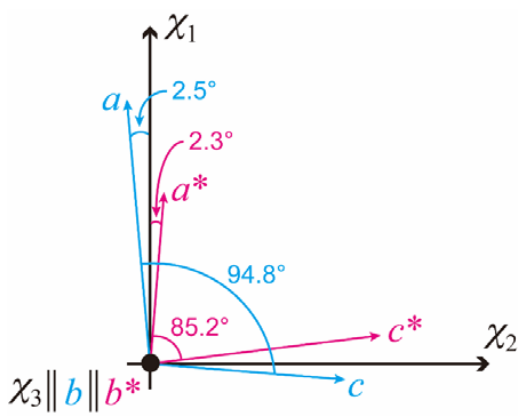
Figure 4. Schematic diagram showing the relationships between the magnetization and crystallographic axes of a PPAZn crystal in real and reciprocal spaces.